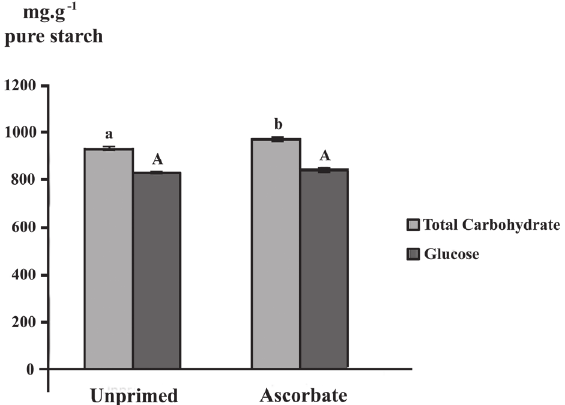
Figure 2 - Total carbohydrate and glucose contents in pure maize starch. Different letters denote significant differences at a confidence level of